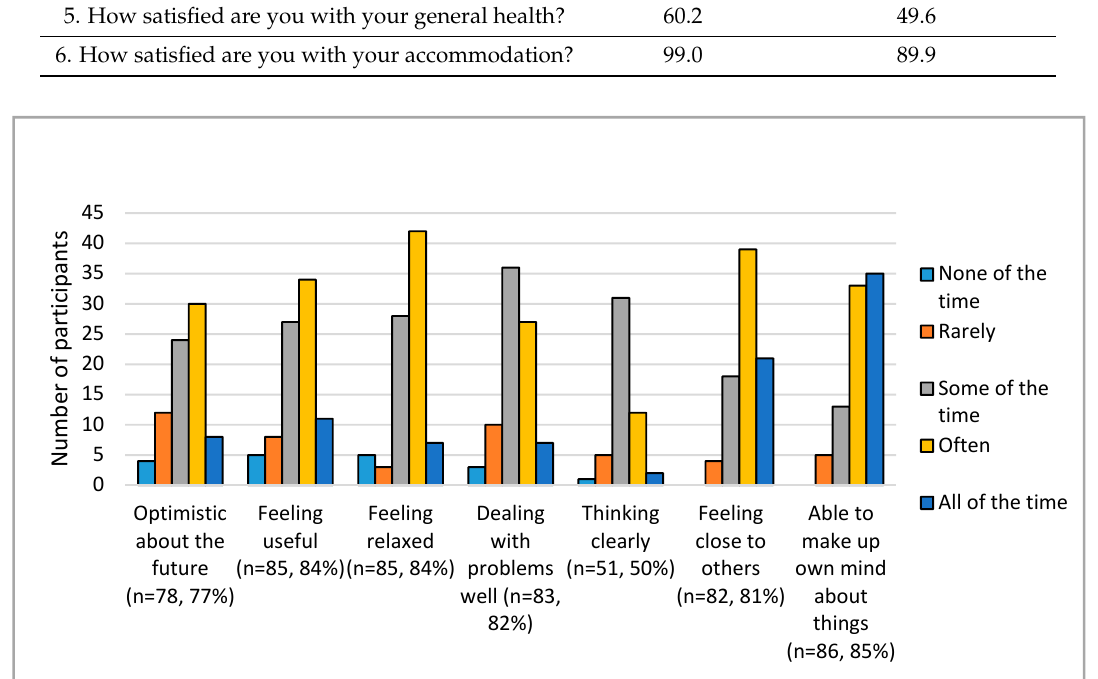
Table 2. Satisfaction scores for intervention participants and the UK population. Percentages for each question refer to respondents indicating any level of satisfaction on the scale.